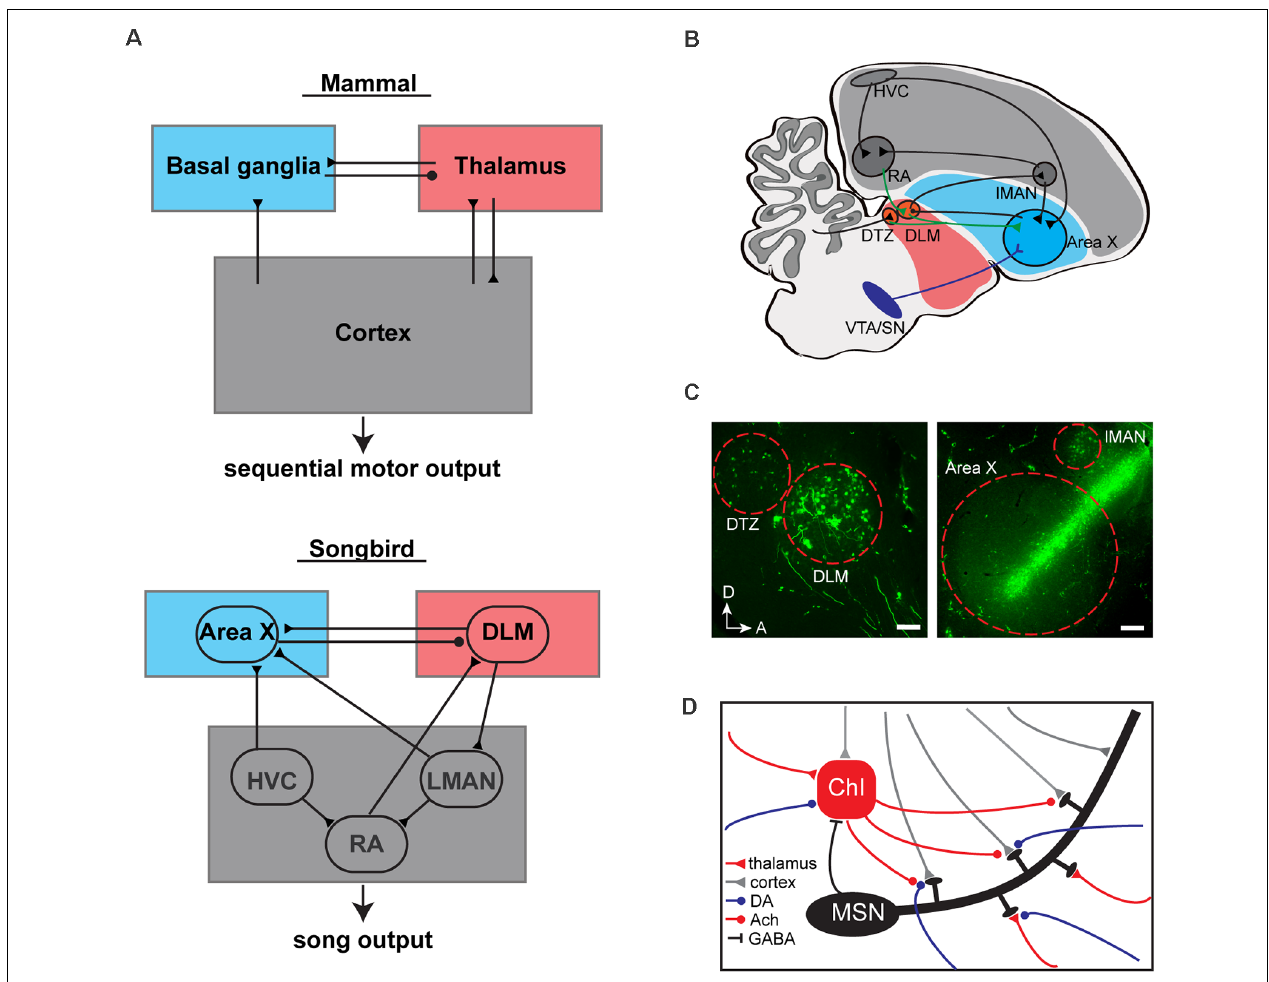
FIGURE 1 | Basal ganglia (BG)-thalamocortical loops in mammals and songbirds. (A) BG-thalamocortical loops are evolutionarily conserved in songbirds and mammals to drive sequential motor (or song) output. Circles and triangles represent GABAergic and glutamatergic inputs, respectively. (B) Schematic of the BG-thalamocortical loops in songbirds. Area X receives multiple inputs from song circuits: glutamatergic inputs from cortical like song circuits HVC and LMAN; glutamatergic inputs from thalamic circuits DLM and DTZ; dopaminergic inputs from midbrain circuits VTA and SN. Circles, triangles, and Y-shaped projections represent GABAergic, glutamatergic, and dopaminergic inputs, respectively. (C) Representative sagittal sections through the thalamus (left panel) and Area X (right panel) when fluorescent tracers were injected into Area X (dextran, Alexa Fluor 488) of adult zebra finch. Left panel, parasagittal section through retrogradely labeled thalamic circuits DLM and DTZ, scale bar, 100 µ m. Right panel, parasagittal section through retrogradely labeled cortical circuit LMAN, scale bar, 200 µ m. D, dorsal; R, rostral. (D) Schematic of striatal microcircuits in mammals. The main glutamatergic inputs to the striatum are from the cortex (gray triangles) and thalamus (red triangles). Both inputs target overlapping populations of MSNs as well as ChIs and other interneurons (not shown). Modulatory inputs from dopaminergic (DA, blue circles) and cholinergic inputs from ChIs (Ach, red circles) are involved in modulating the synapses onto MSNs. MSNs provide GABAergic inputs to ChIs (black